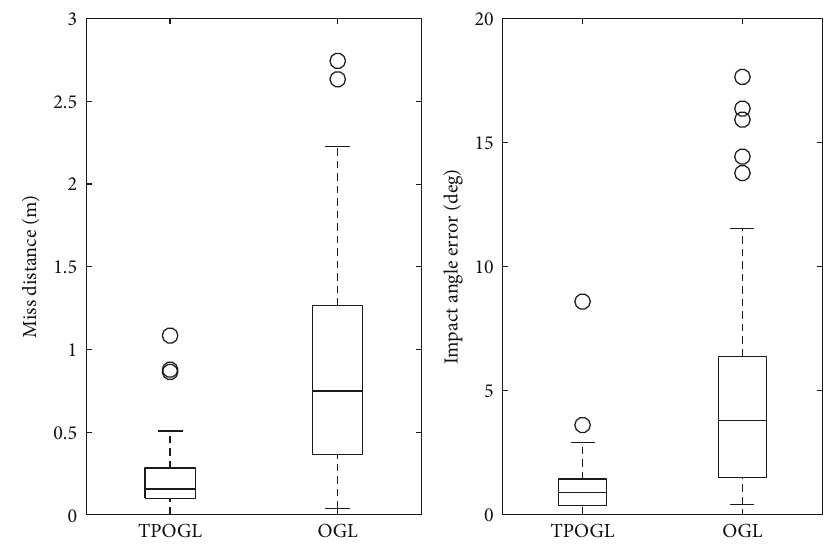
Figure 11: Distributions of errors against maneuvering